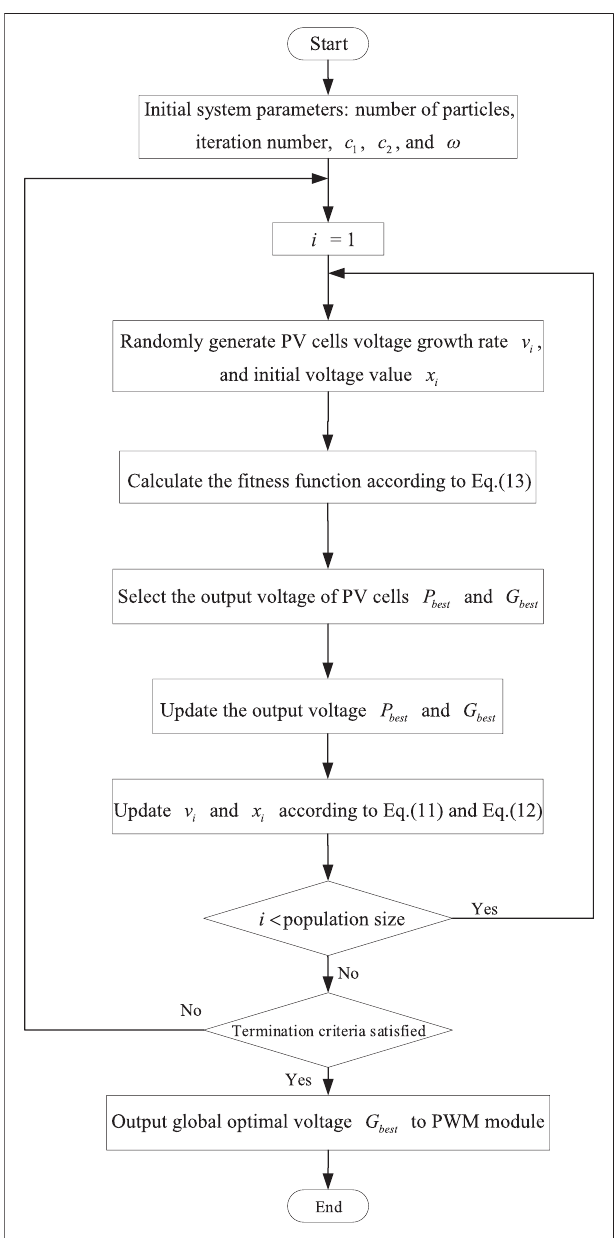
FIGURE 4 | Online PSO variable step length MPPT control fl ow